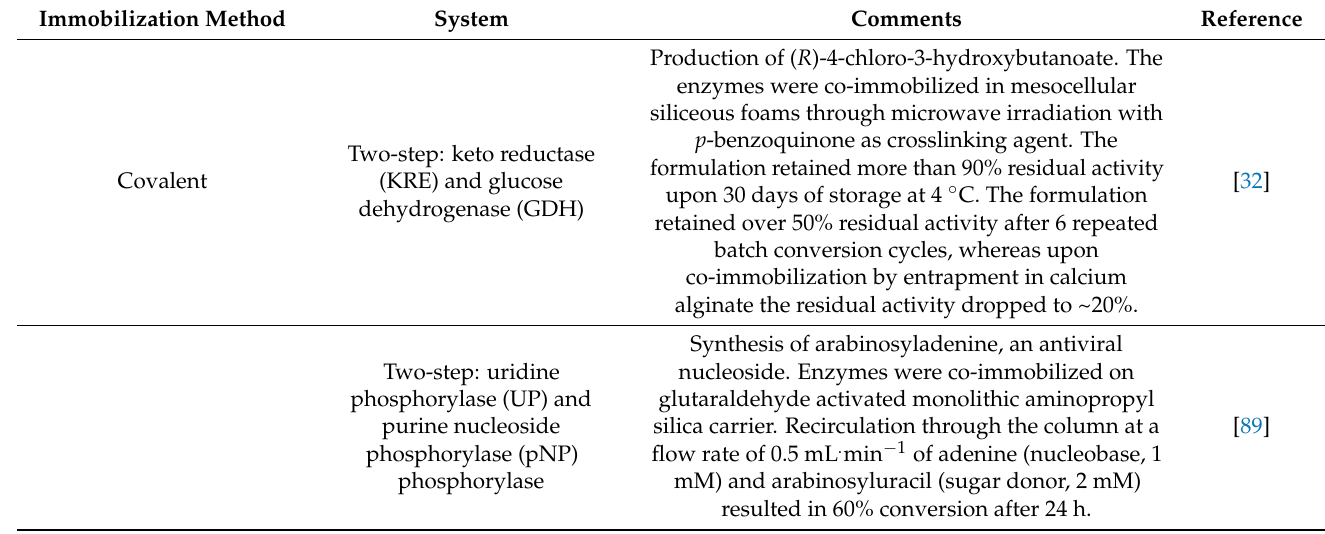
Table 2. Recent examples illustrative of the use of different methods for the immobilization of enzyme cascades. Immobilization